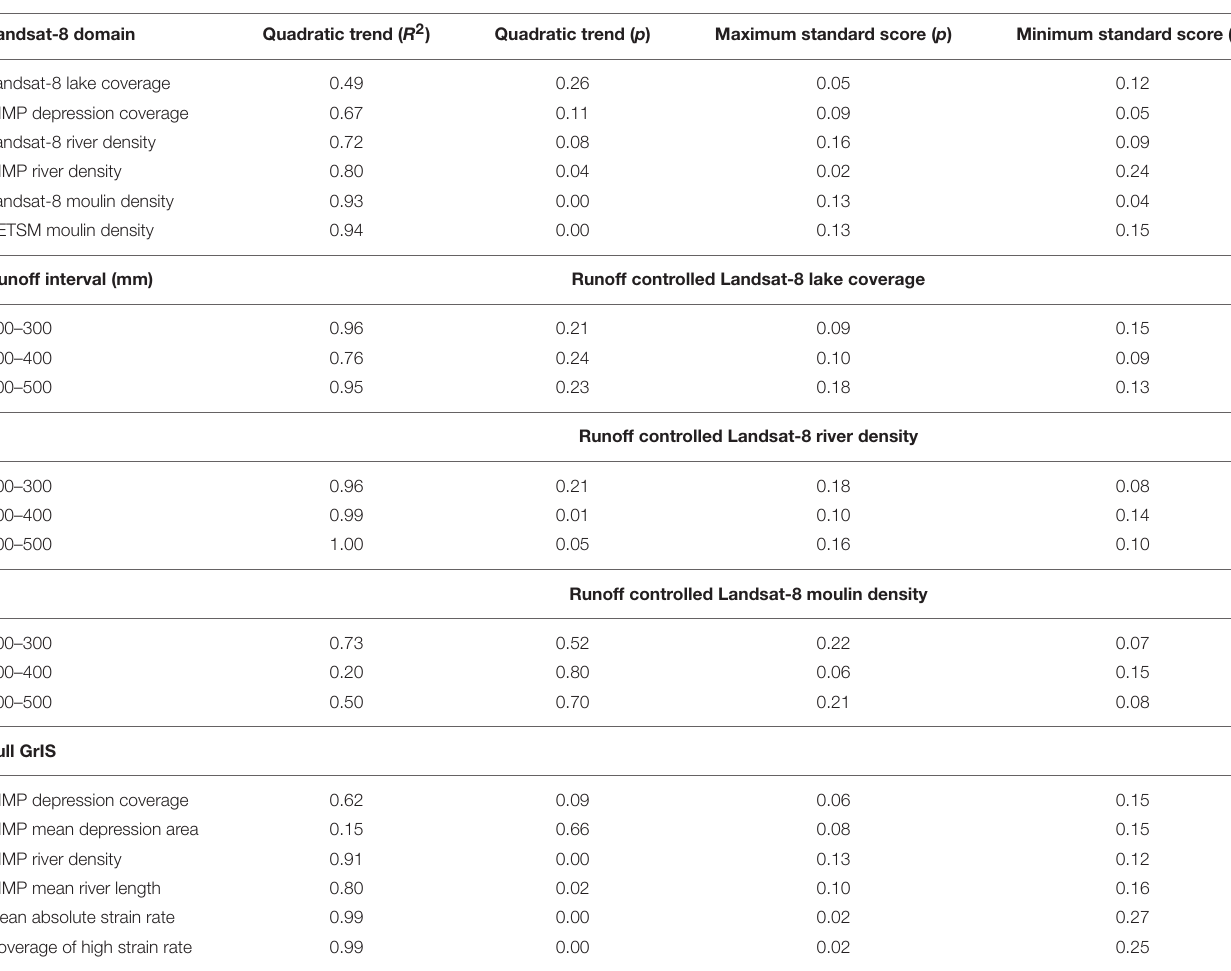
TABLE 1 | Coefficients of determination ( R 2 ) and p -values of the quadratic models fitted on different inferential characteristics (e.g., density, coverage) of our Landsat-8, GIMP-DEM, and SETSM-DEM derived surface drainage features, principal strain rates and observed mean surface